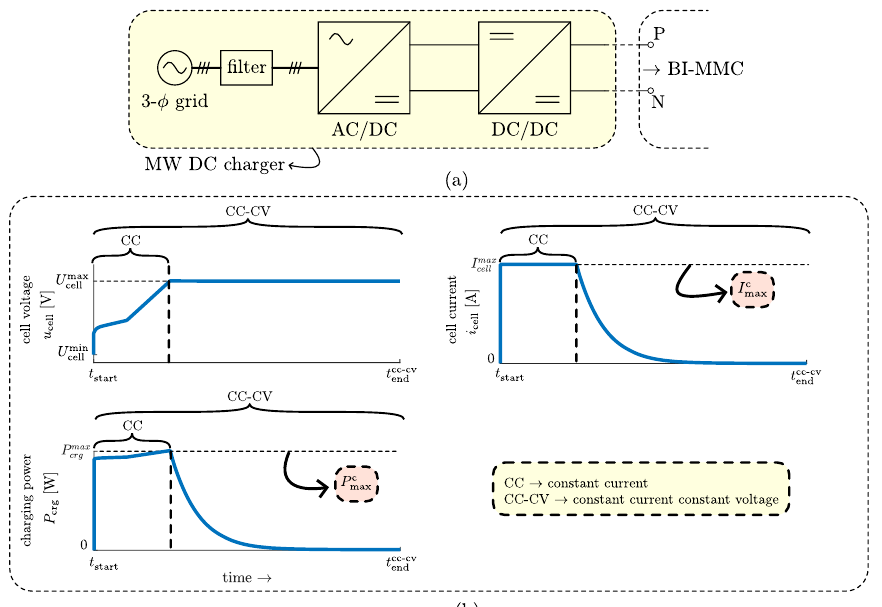
Figure 2. Schematic of a megawatt DC charger and different charging strategies. ( a ) megawatt Dc charger schematic and ( b ) the constant current constant voltage (CC-CV) and constant current (CC) charging